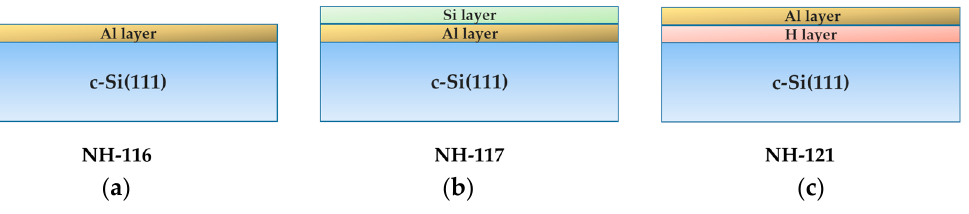
Figure 1. Schematics and naming of the fabricated samples: ( a ) NH-116 consisting of a monolayer of Al; ( b ) NH-117 consisting of monolayers of Si/Al; ( c ) NH-121 consisting of monolayers of